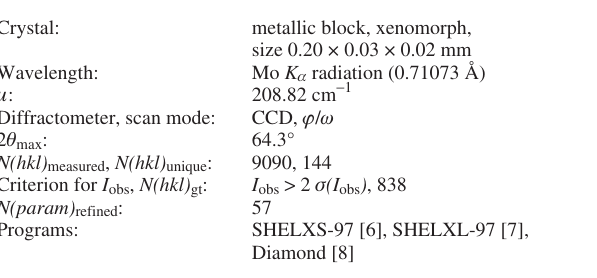
Table 1. Data collection and